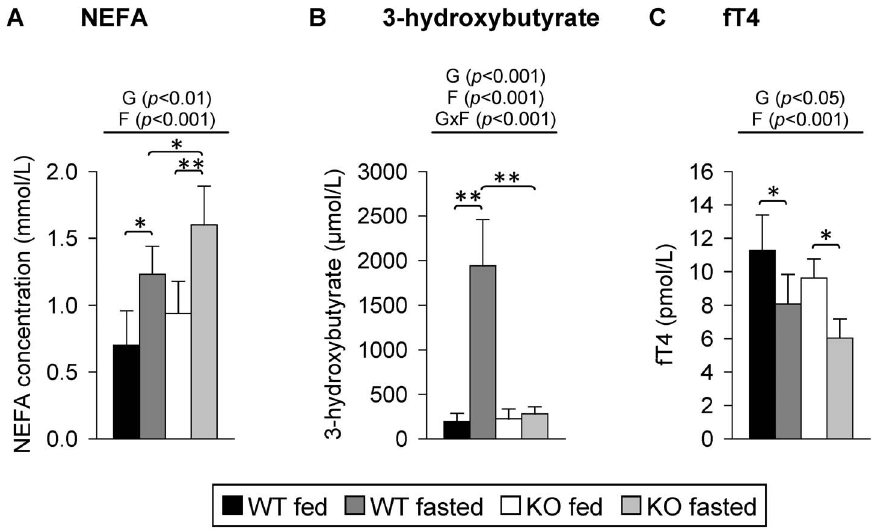
Figure 1. Final plasma concentrations of (A) non-esterified fatty acids (NEFA), (B) 3-hydroxybutyrate and (C) free thyroxine (fT4) in response to fasting and PPAR a . Values represent means 6 SD of plasma concentrations of wildtype (WT) and PPAR a knockout (KO) mice that were fed ad libitum or fasted for 48 h (n=16 for 3-hydroxybutyrate, n=8 for NEFA and fT4). Data were analyzed by two-way ANOVA. Classification factors were genotype, fasting, and the interaction between both factors. P -values revealed by two-way ANOVA are noted above the figures. Individual means of the treatment groups were compared by Tukey’s test in case of variance homogeneity. In case of variance heterogeneity, as revealed by Levene’s test, individual means were compared by Games Howell test. Horizontal brackets represent differences between groups in post- hoc comparison (** p , 0.001, * p , 0.05).